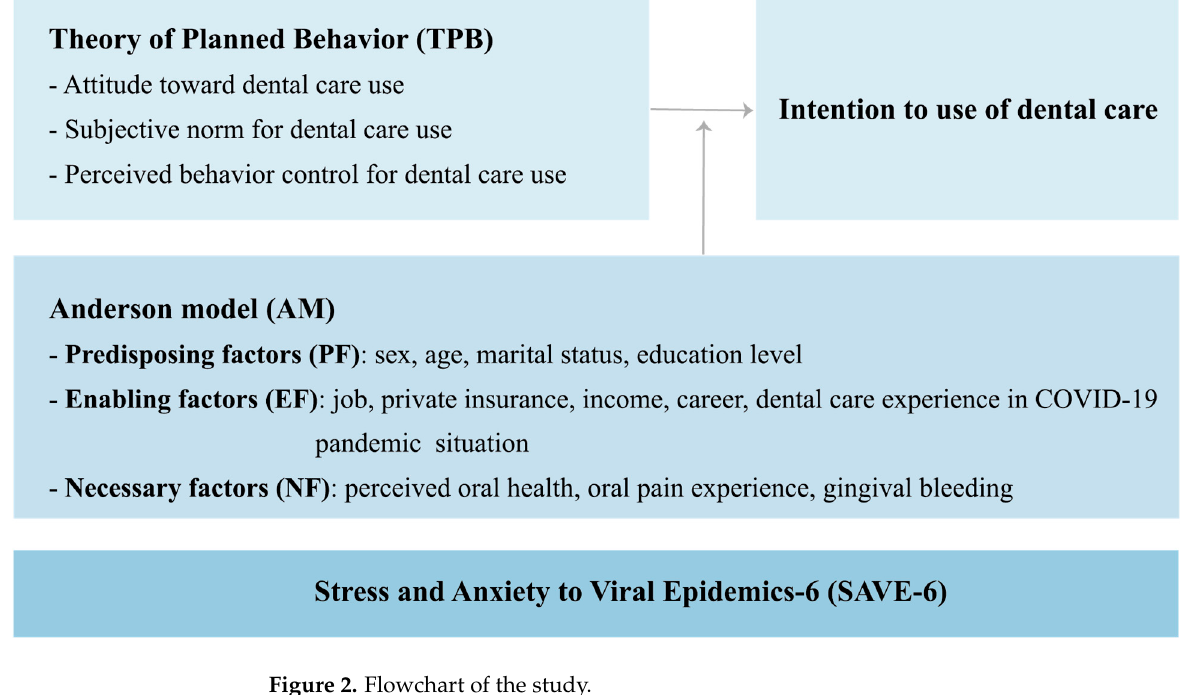
Figure 2. Flowchart of the study.